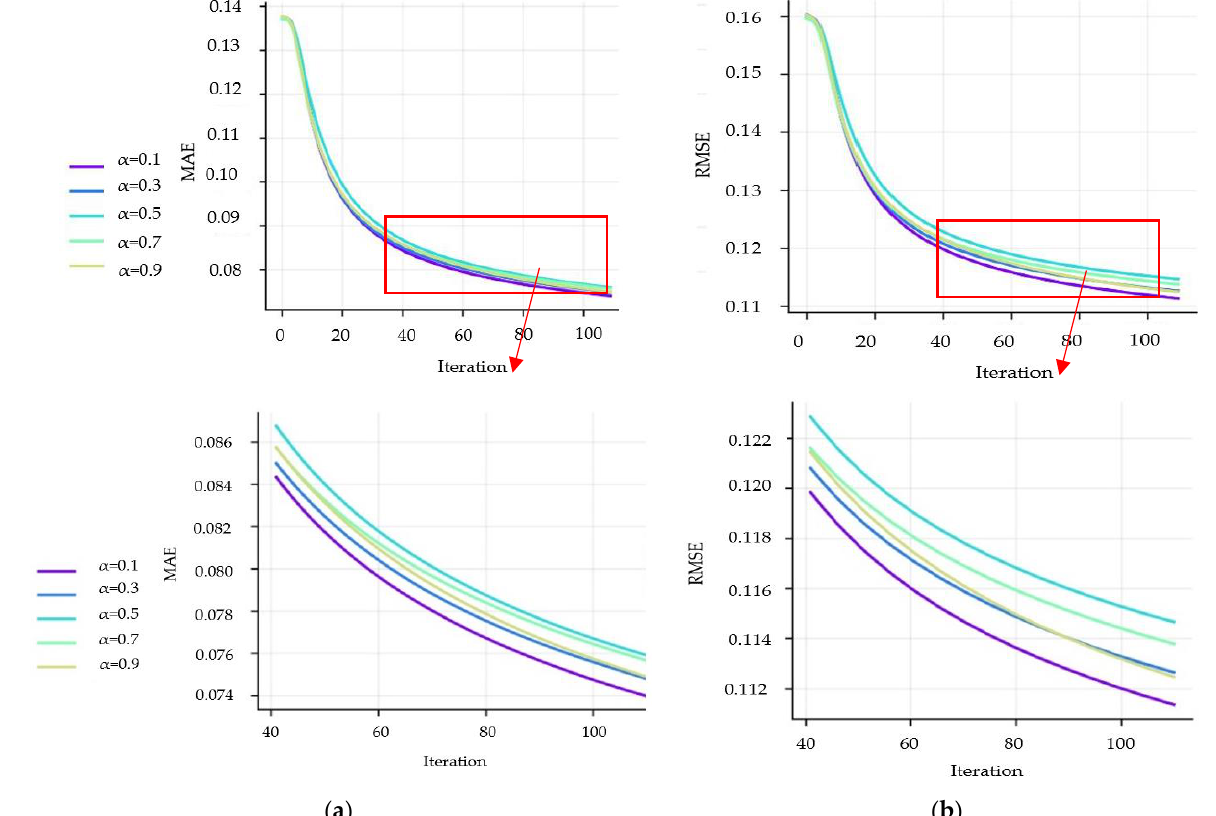
Figure 5. Impact of β on MAE (a) and RMSE (b).